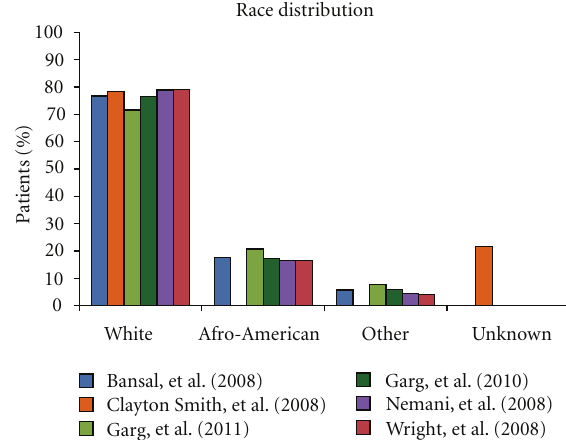
Figure 1: This column-graph demonstrates the race distribution among the six chosen index large case-based series of Bansal et al. [8], Clayton Smith etal. [9], Garg et al. [10], Garg et al. [11], Nemani et al. [12], and Wright et al. [13]. The y -axis indicates the percentage of patients in the respective study that fall into each category. Contradictory to the commonly held belief that Afro- Americans are more likely to develop uterine carcinosarcoma than Caucasians, all six studies had a white population much greater than the Afro-Americans.